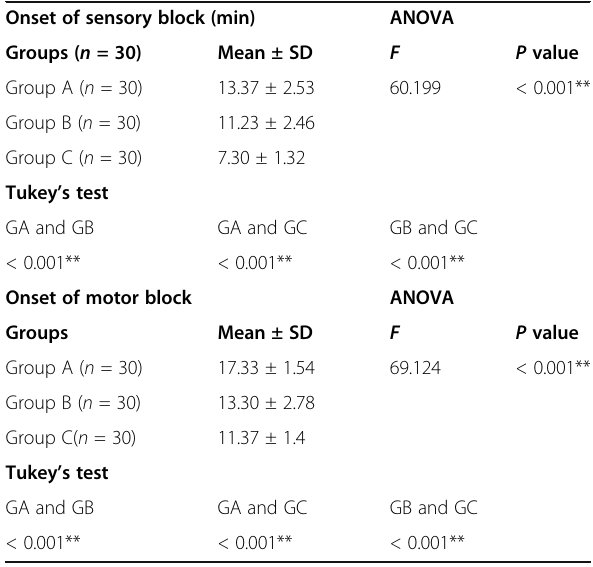
Table 2 Comparison between the three groups as regards onset of sensory and motor block